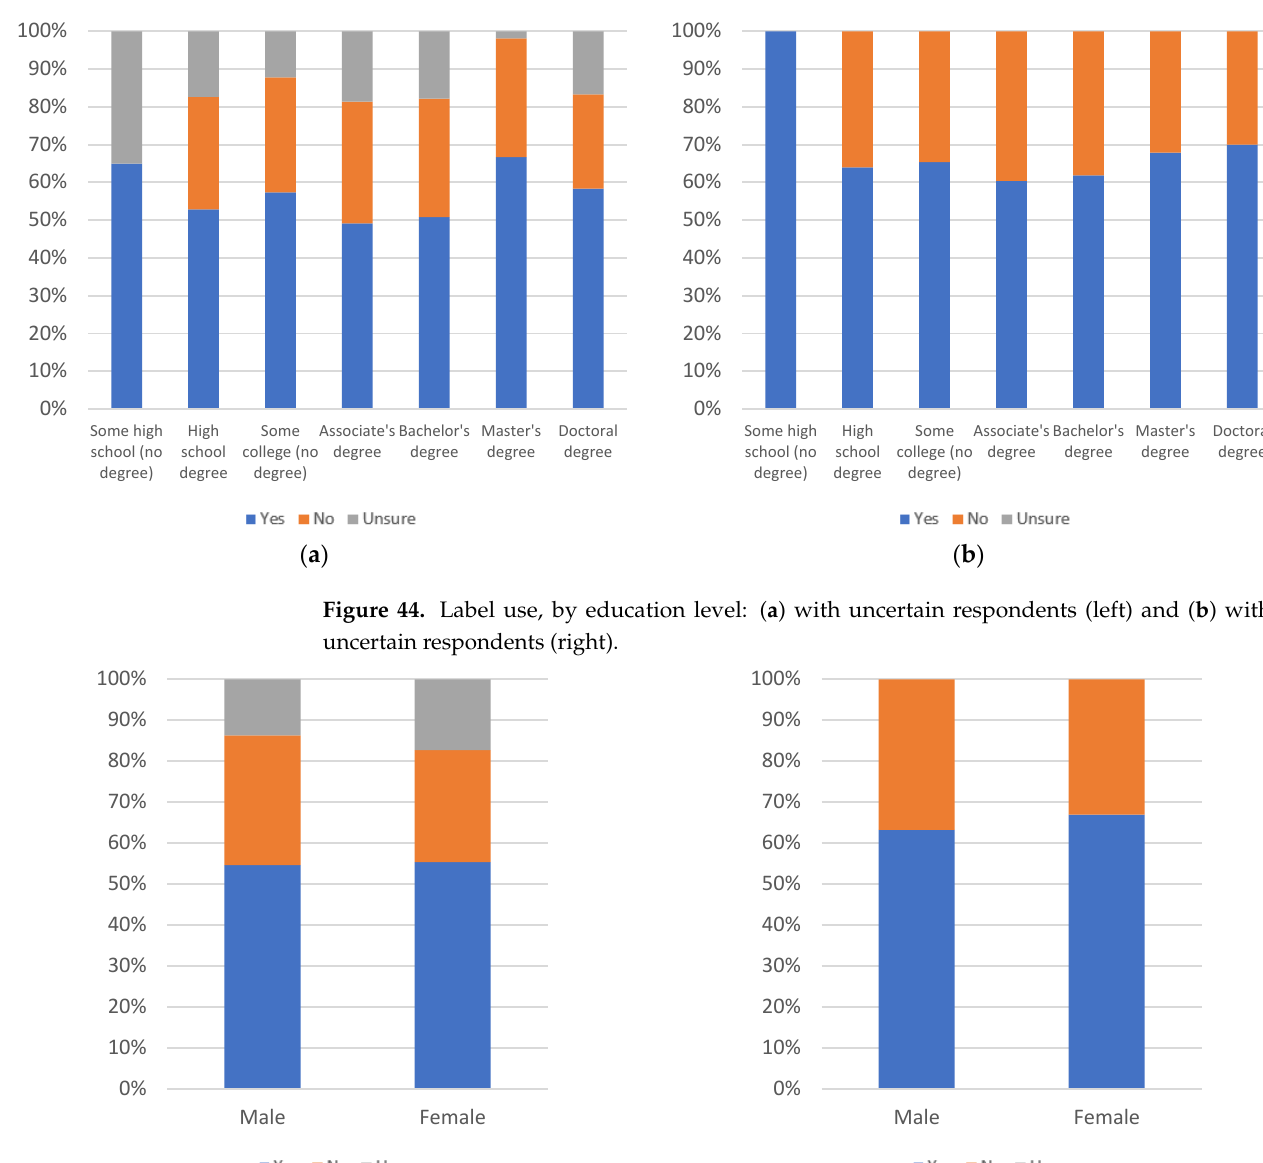
Figure 43. Label use, by age group: ( a ) with uncertain respondents (left) and ( b ) without uncertain respondents (right).